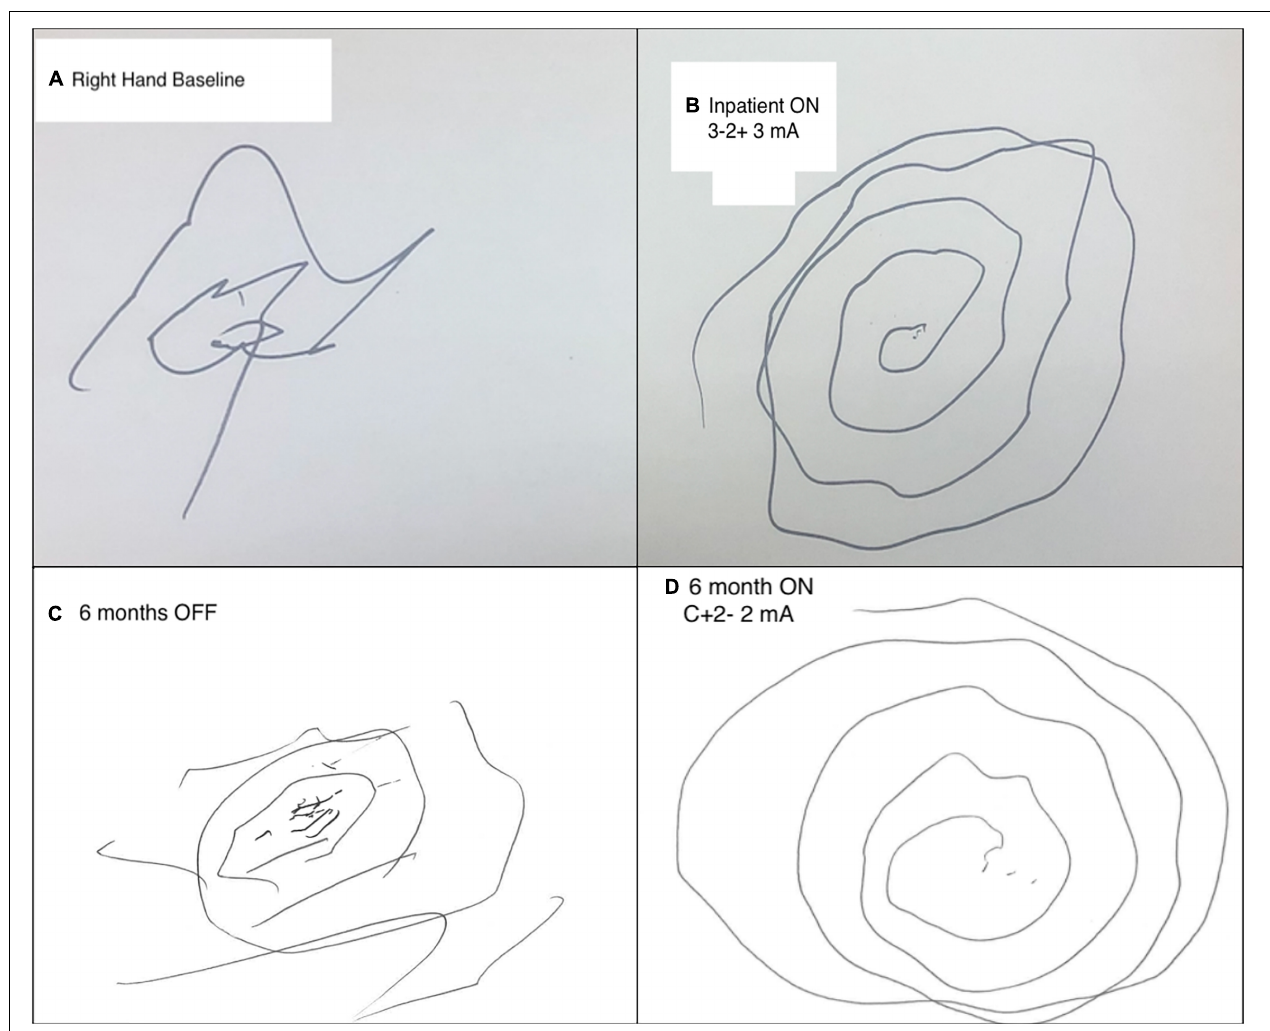
FIGURE 1 | Comparison of pre- and post-operative spiral draw testing. (A) Preoperative baseline attempt at Archimedes spiral drawing with the right hand severely limited by tremor burden. (B) Spiral drawing with the right hand during inpatient extra-operative externalized testing. Left Vim configured on bipolar (3-2+) settings at 3 mA, 60 µ s, and 130 Hz. (C) 6-month post-operative spiral drawing with the right hand OFF Vim stimulation. (D) 6-month post-operative spiral drawing with L Vim turned on final setting configuration: 2 mA, 70 µ s, and 150